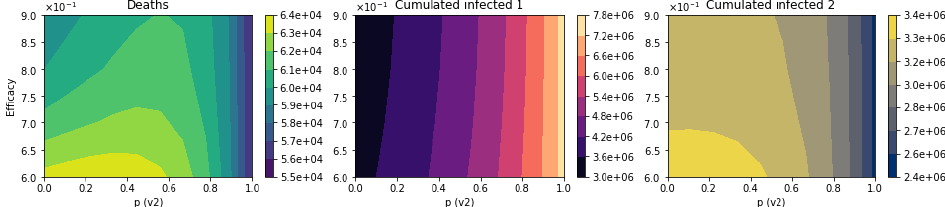
Figure 15. Total number of deaths and the cumulative number of infected people for each age